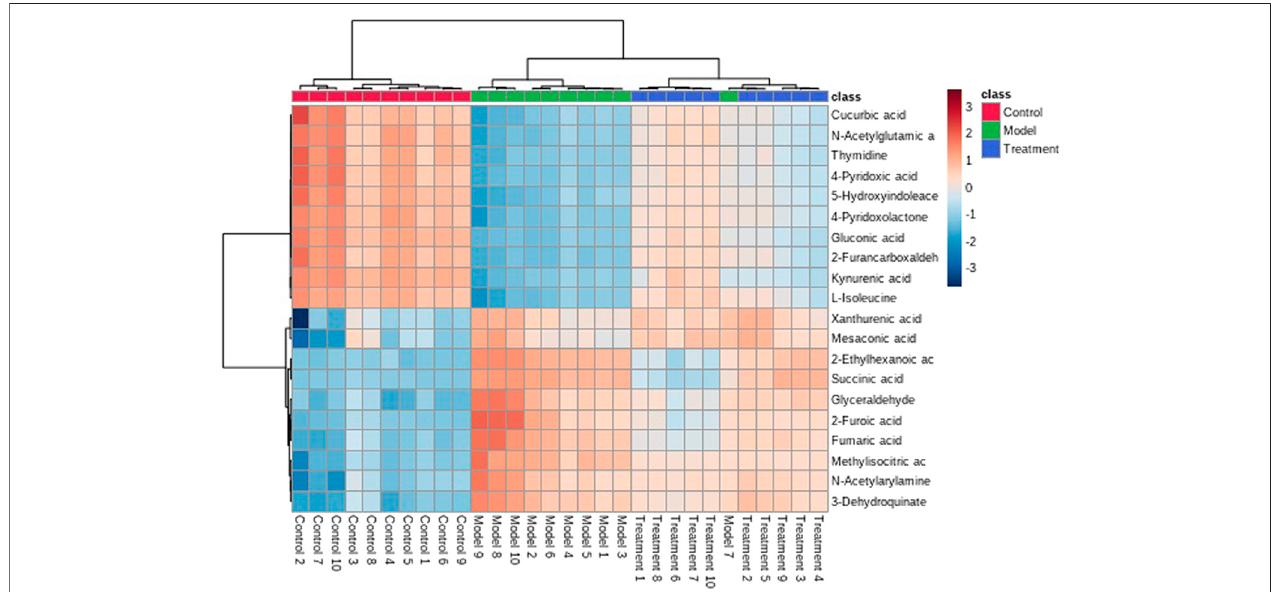
FIGURE 8 | Cluster analysis of the differential metabolites in the control, model, and treatment